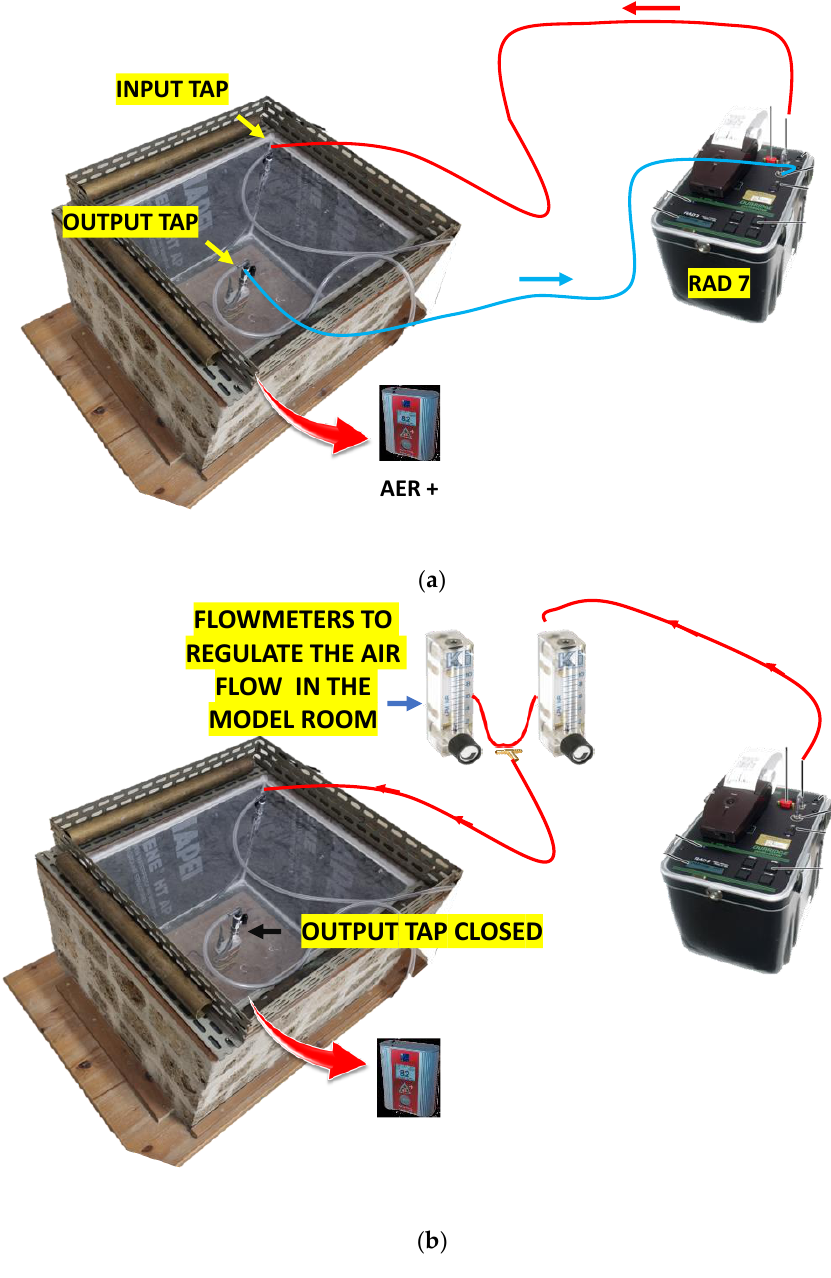
Figure A1. Experimental configurations used in parts 1 and 2 ( a ) and in parts 3, 4, and 5 ( b ) of the tests. The red arrows indicate that the AER PLUS monitor was placed in the model room.